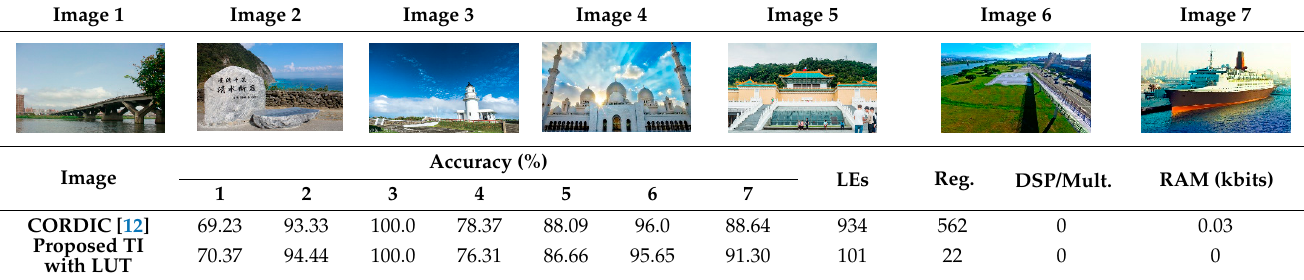
Table 3. Accuracy and hardware comparison for proposed TI with LUT and CORDIC algorithm. Image 1